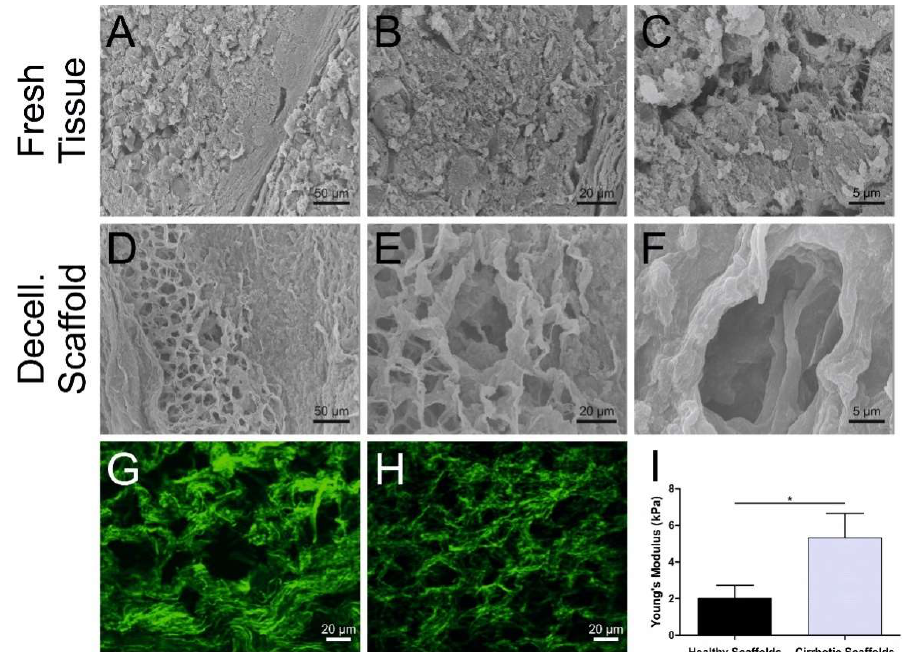
Figure 2. Microscopic characterization of decellularization of human liver 3D scaffolds. ( A – F ) SEM imaging of native tissue (top panel, A – C ) and decellularized 3D cirrhotic sca ff olds (bottom panel, D – F ) showing the preservation of the nodular fibrotic ECM and conservation of the hepatocyte pockets (scale bars 50 µm, 10 µm, and 5 µm for each condition). ( G ) Second harmonic generation analysis of fibrillar collagens structure (green) of healthy decellularized 3D scaffolds with ( H ) more abundant and compact fibrillar collagen structures present in cirrhotic decellularized 3D scaffolds (scale bars, 20 µm). ( I ) AFM comparison of tissue stiffness between healthy decellularized 3D scaffolds and cirrhotic decellularized 3D scaffolds: Healthy scaffold 2.03 ± 0.59 kPa and cirrhotic scaffold 5.25 ± 1.09 kPa. Data are expressed as mean ± SEM, * p = 0.0118, unpaired t-test).